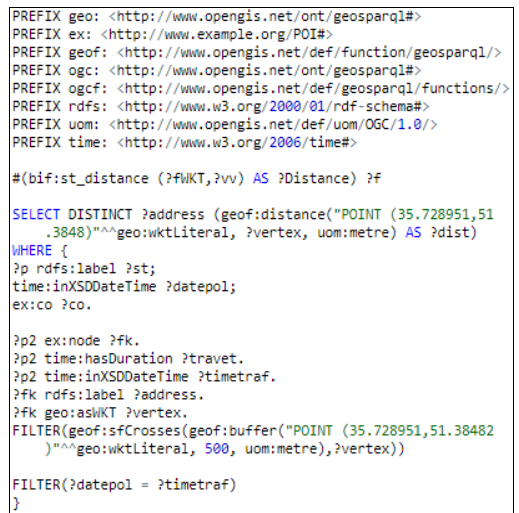
Figure 2. Example of a GeoSPARQL query to extract label and distance of ways to user's position.